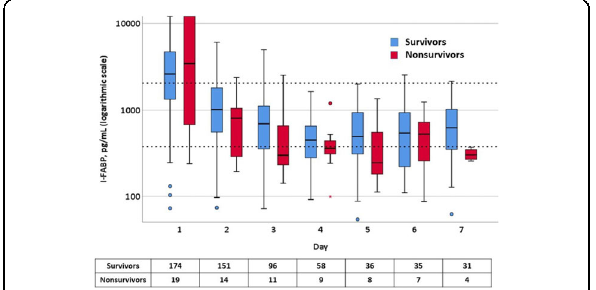
Fig. 2 (abstract 000698). Plasma I-FABP dynamics in 28 days survivors vs nonsurvivors